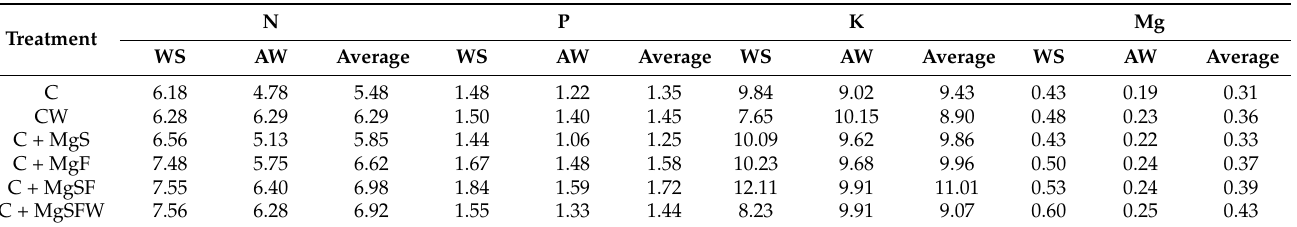
Table 4. The total nutrient uptake of tomato plants in different treatments of Mg fertilizers application (g plant − 1 ).